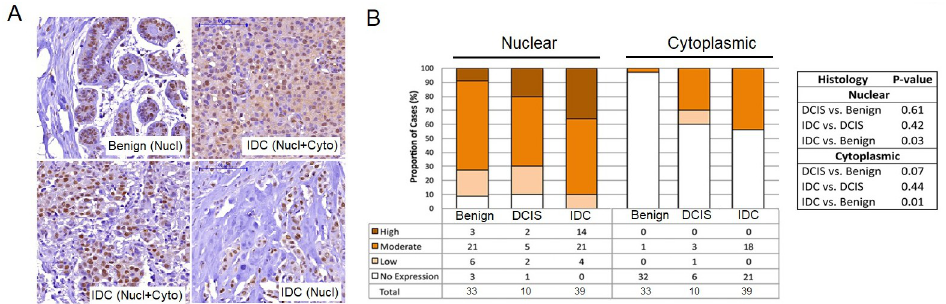
Fig 5. Increased expression of MELK proteins in invasive ductal carcinoma (IDC) compared to benign tissues. (A) Representative images from immunohistochemistry (IHC) analyses of MELK protein expression in benign epithelia and IDC tissues. MELK expression was interpreted using the ImmunoReactive Scoring system (IRS), on a scale of 0–12, as no/low (scores 0–3, negative) and moderate/high (scores 4–12, positive). Benign tissue with only nuclear (Nucl) expression (moderate IRS score 8) in 90% of cells is shown. IDC from a luminal A tumor presented with moderate MELK expression in both nuclei (score 8) and cytoplasm (score 4) (Nucl+Cyto). Examples of two MELK - positive IDCs of the same histological grade 3 and stage 2A, showing the presence and absence of cytoplasmic staining, respectively. (B) Nuclear and cytoplasmic expressions of MELK proteins are quantified in benign, DCIS and IDC tissues, which was significantly higher in IDC compared to benign tissues (p = 0.03 and 0.01, respectively). Bars represent the proportion of cases with the given resignation. P -values were calculated using either Kendall’s tau-b for group comparison or cumulative link mixed models for pairwise comparisons and adjusted by Holm’s